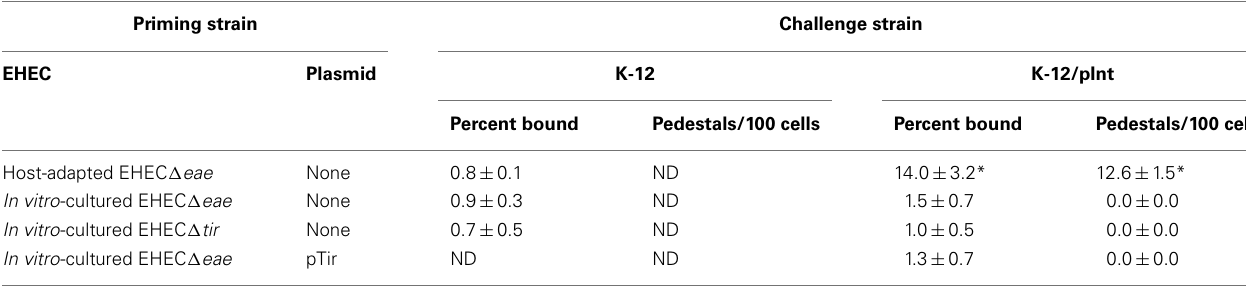
Table 2 |Translocation of functionalTir is enhanced upon host